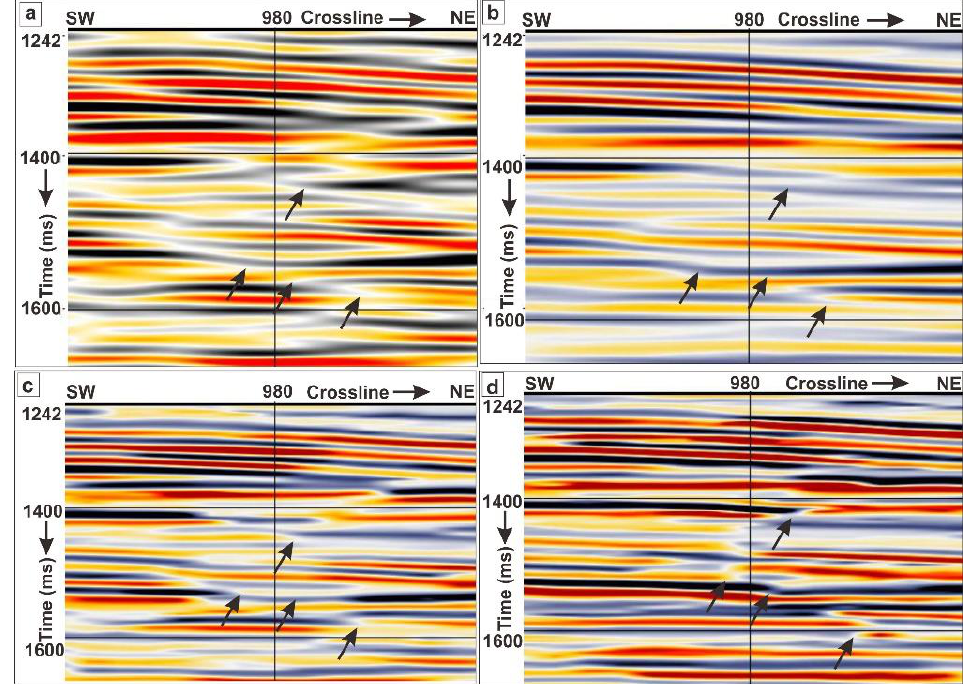
Figure 3. Seismic sections at inline 665: ( a ) original seismic data; ( b ) dip-steered median filter (DSMF) data; ( c ) dip-steered diffusion filter (DSDF) data; and ( d ) fault enhancement filter (FEF) data. The black arrows show the differences in the identified discontinuities. The FEF shows the best results of identifying the discontinuities.